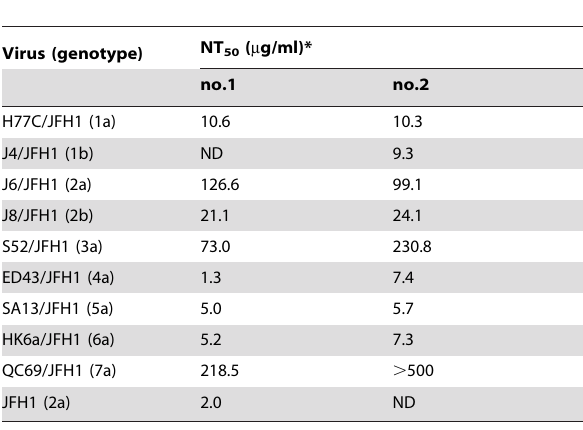
Table 2. 50% neutralization titers (NT 50 ) of # 55 by FFU reduction.